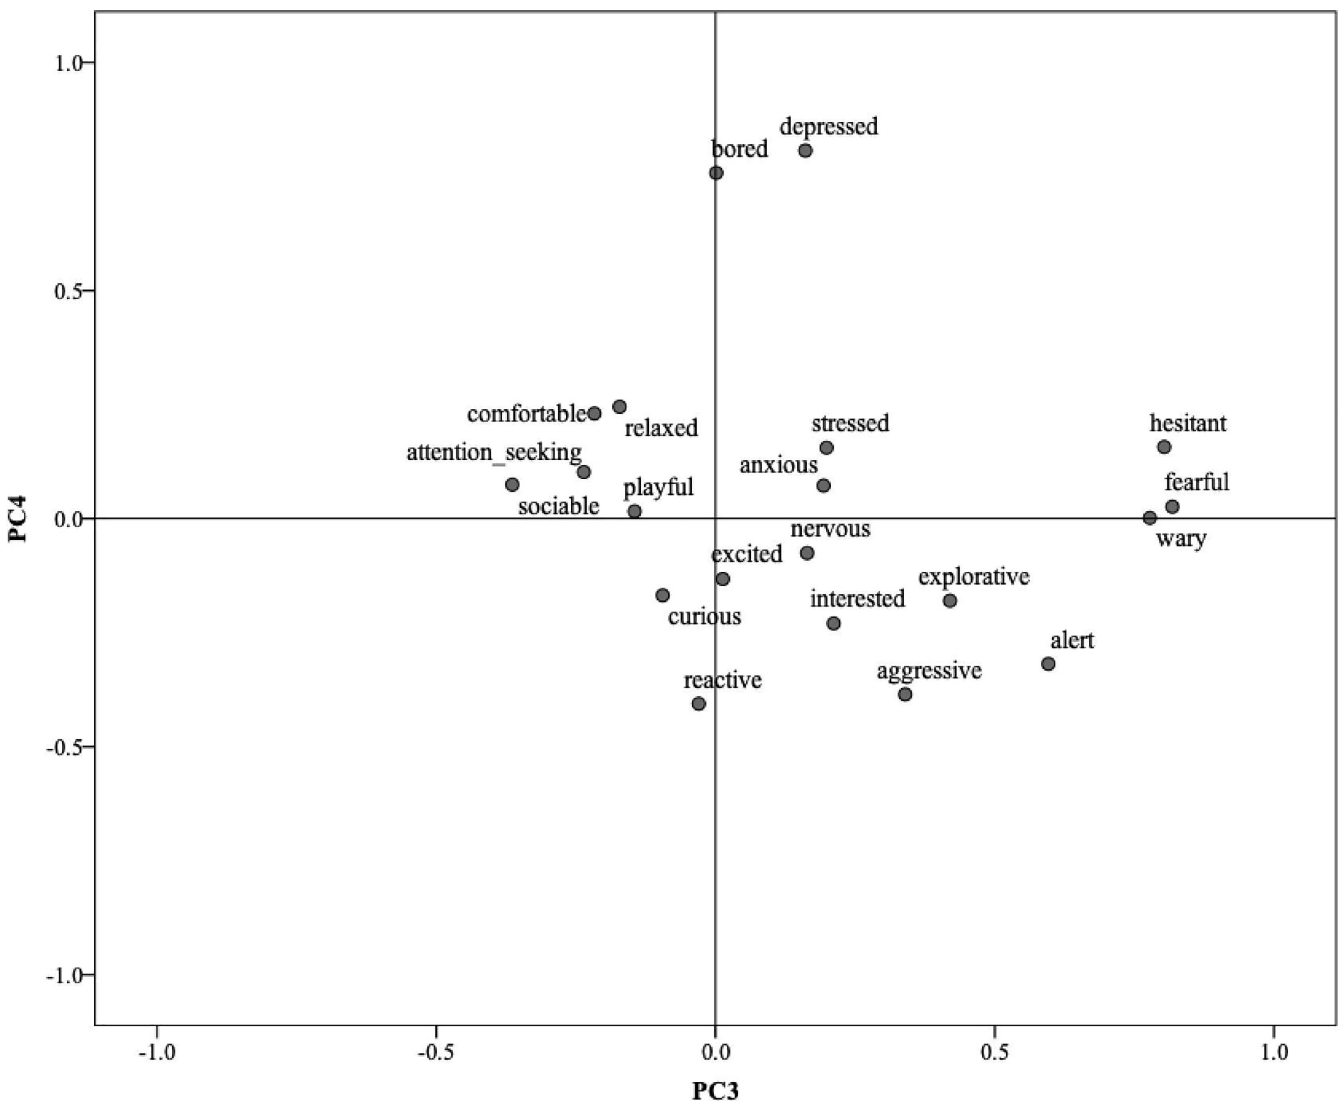
Fig 2. Distribution of the 20 QBA terms on Principal Component 3 (PC3) and Principal Component 4 (PC4).